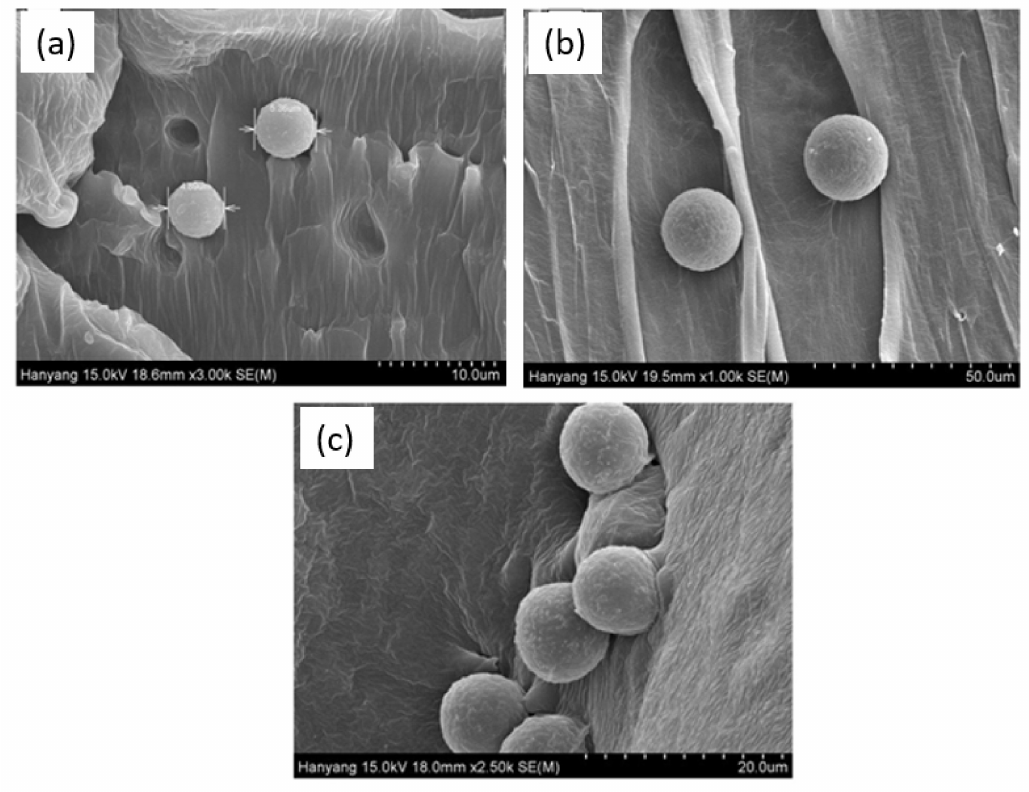
Figure 9 . SEM images of composites ( a ) 5 µ m ( b ) 10 µ m and ( c ) 20 µ m PMMA bead composites. The mechanism whereby the MWCNT-coated PMMA beads enable resistance